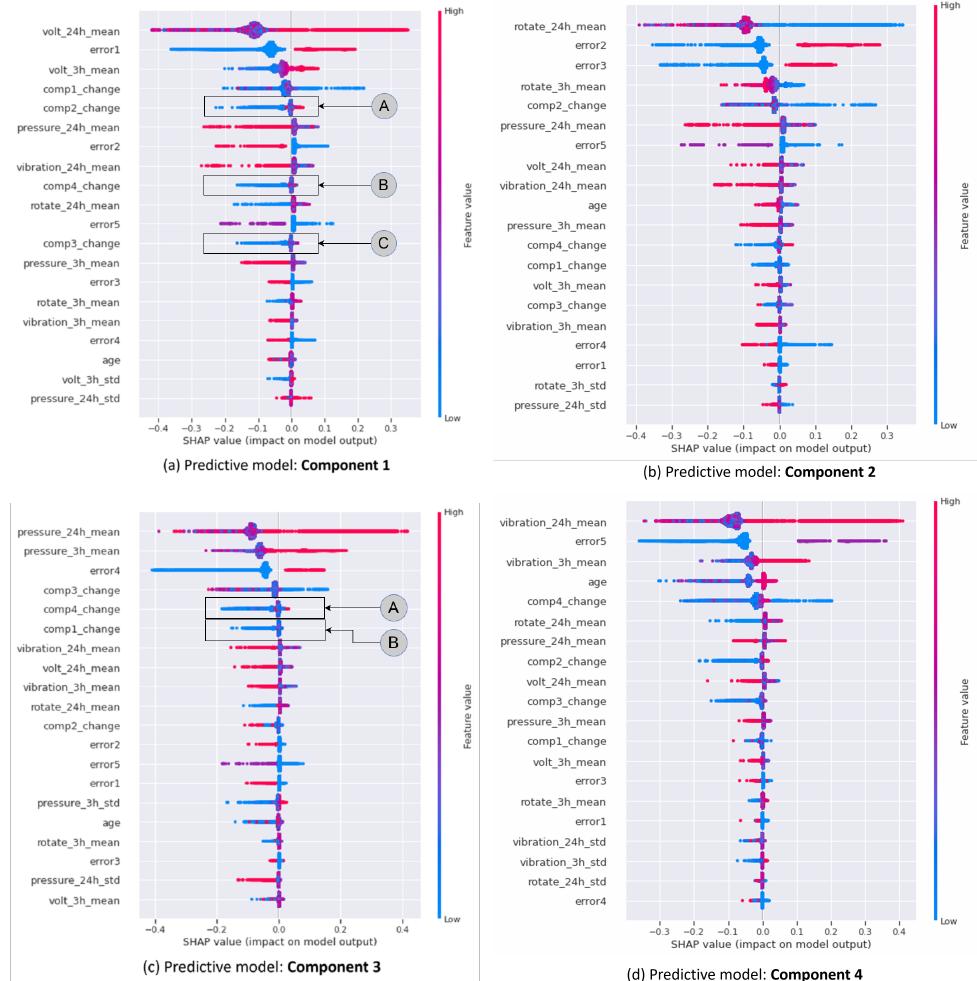
Figure 7. Model explainability for every single component using SHAP. The results show the presence of interdependencies between components altogether with the positive/negative impact with respect to the value magnitude. For instance, concering the component 1 failure prediction (section ( a )) it is visible that that an worn out of component 2 contributed more on prediction of the failures, respectively a newly changed component 2 contributed